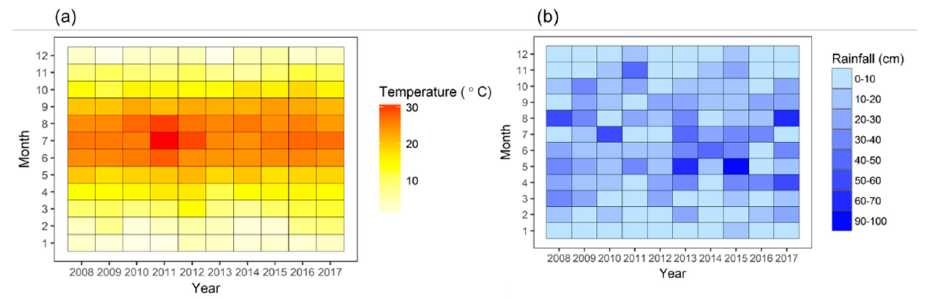
Figure 3. Seasonal distributions of air temperature ( a ) and precipitation ( b ).